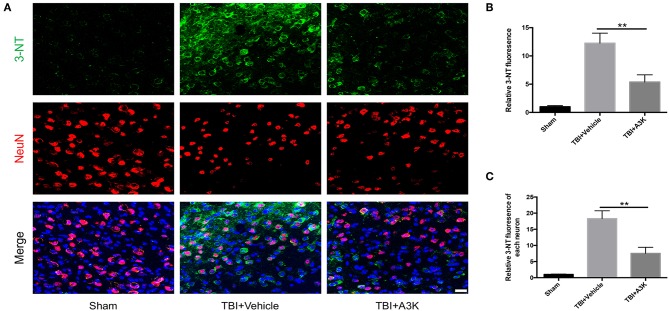
Serpina3k attenuated the total and individual neuron expression of 3-NT at 7 days after TBI. (A) Representative immunofluorescence images of 3-NT and NeuN in the peri-contusion areas of brain tissue from the sham, TBI+vehicle, and TBI+A3k groups. Scale bar = 10 μm. Quantified expression of total 3-NT (B) and each neuron's 3-NT (C). Data represent the mean ± SD (n = 5 per group). **P <0.01, TBI+A3K group vs. TBI+vehicle group.